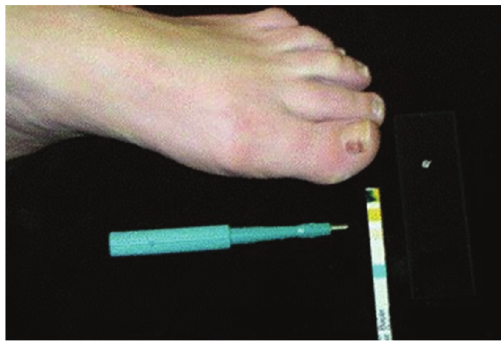
Figure 2: Trocar, Glass slide with scrapped nails, and Hemocult stick showing the result.